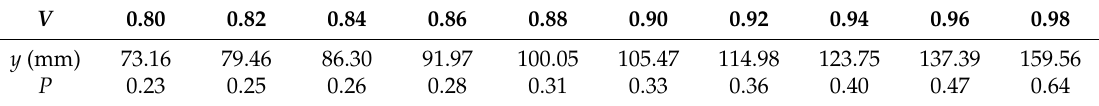
Table 4. The conditional probability that P ( X > x f | Y > y ) at y = 73.16, 79.46, 86.30, . . . , 159.56 mm.